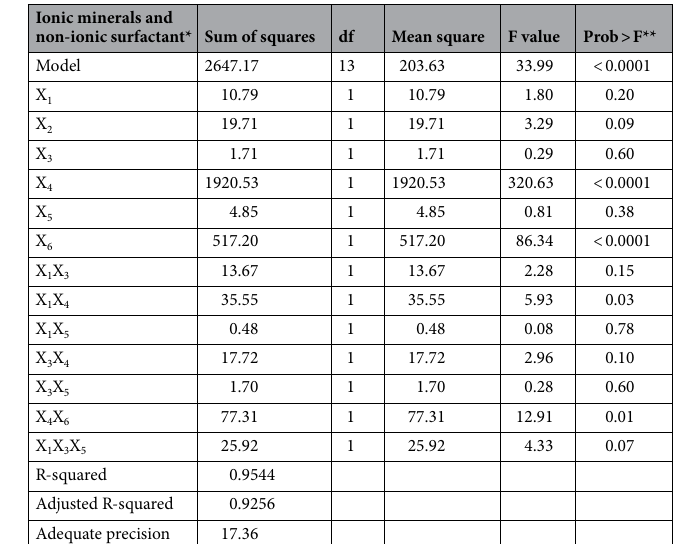
Table 5. ANOVA analyses for FFD models of ionic minerals and non-ionic surfactant on the antimicrobial activity of postbiotic RS5 produced by L. plantarum RS5. *X 1 : Sodium acetate; X 2 : Di-potassium hydrogen phosphate; X 3 : Di-ammonium hydrogen citrate; X 4 : Tween 80; X 5 : Magnesium sulphate heptahydrate; X 6 : Manganese sulphate tetrahydrate. **Value of “Prob > F” less than 0.05 indicate model terms are significant.